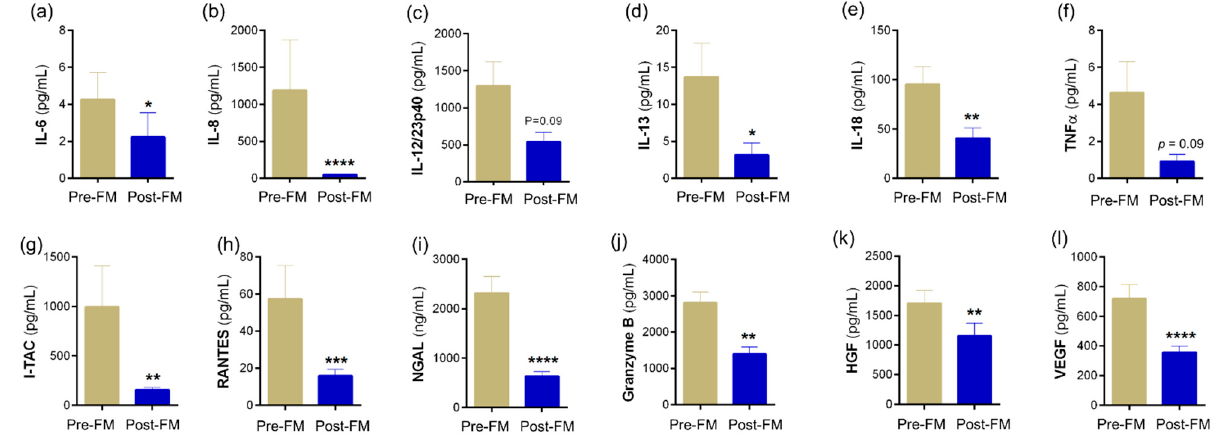
Figure 3. Tear fluid soluble factors decreased during face-mask-wearing era. Bar graphs